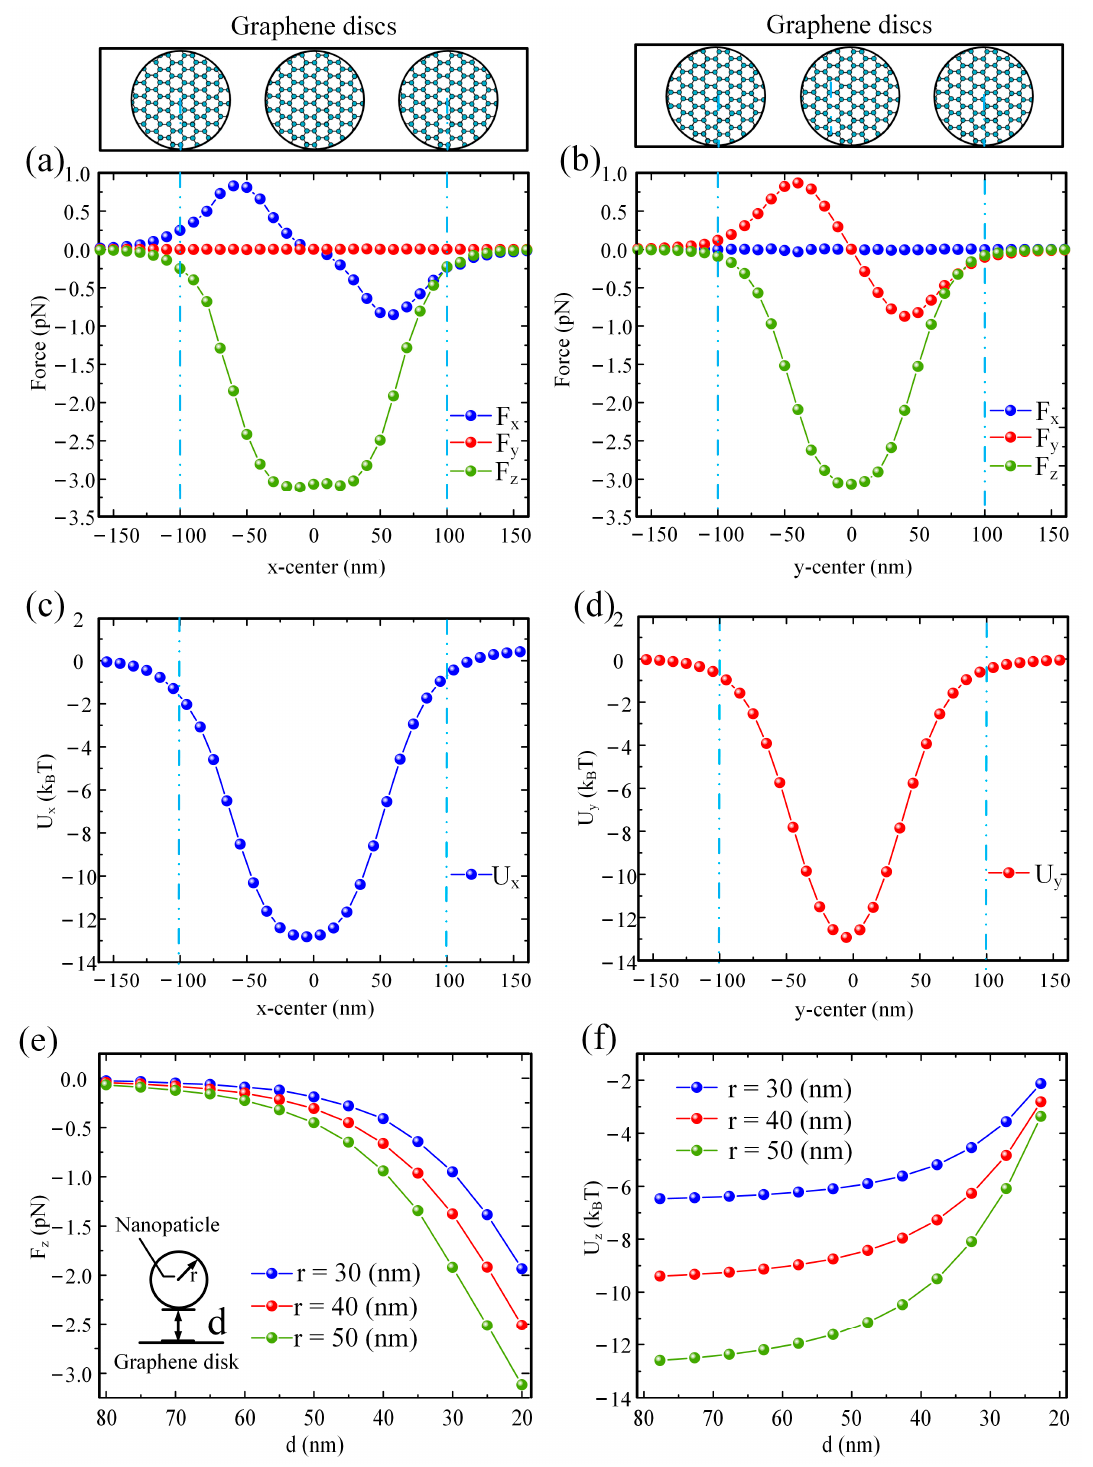
Figure 3. The components of the optical force on the nanoparticle ( n = 1.6) and the corresponding trapping potential are calculated by the MST method. ( a , c ) The center of the nanoparticle is on the x -axis. ( b , d ) The center of the nanoparticle is on the y -axis. ( e , f ) The center of the nanoparticle is in the x -axis, z-center, r = 30, 40, and 50 nm, respectively.